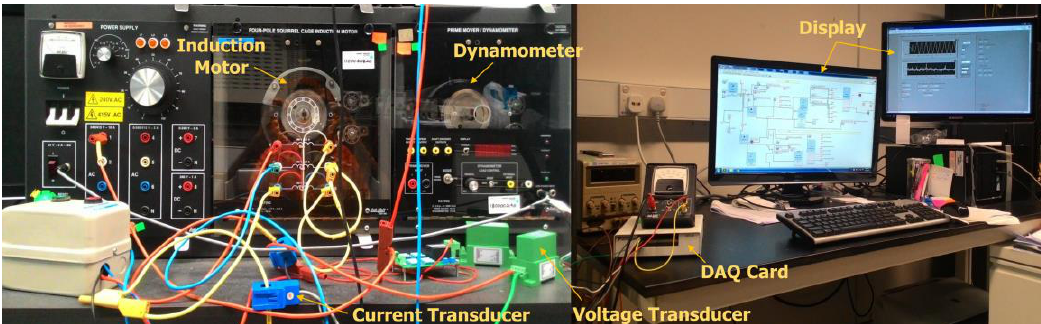
Figure 4. The developed experimental test rig.